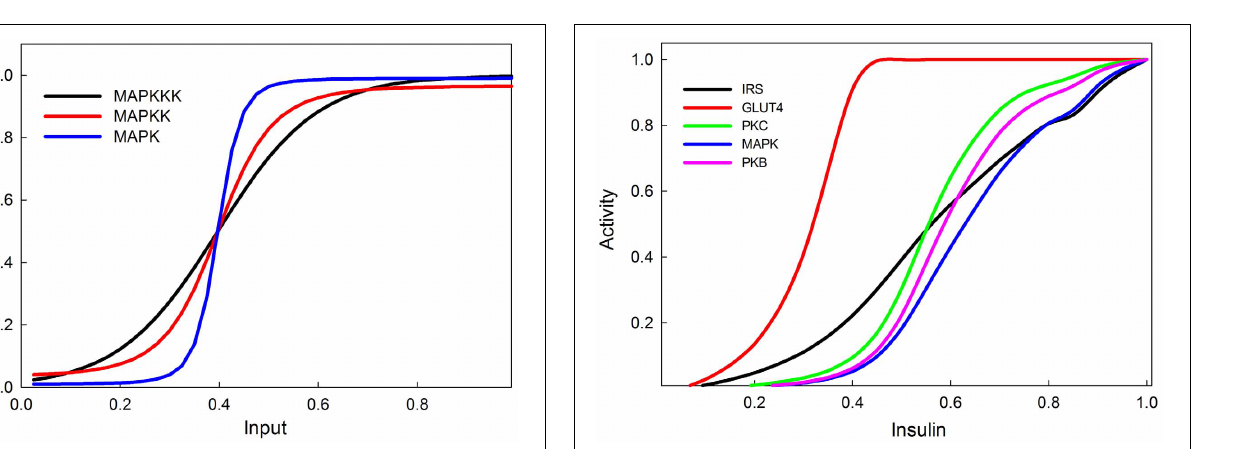
insulin concentration scale. The dose-response of INR phospho-